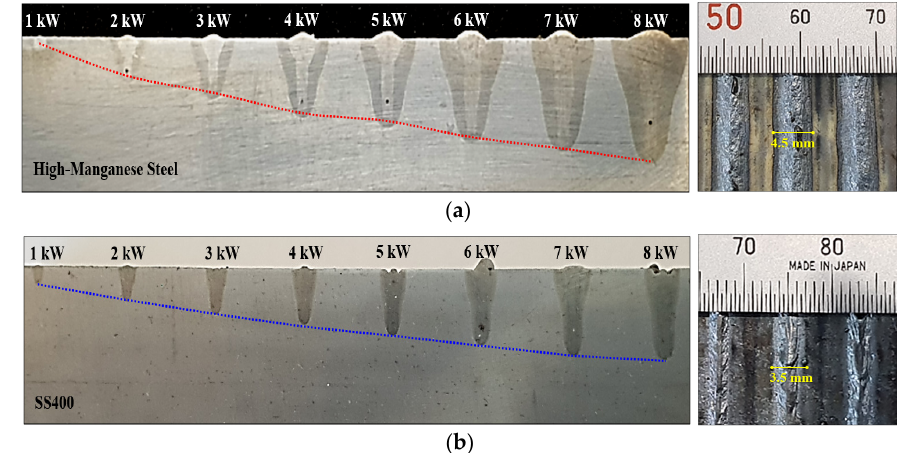
Figure 3. Comparisons between the penetration depths and weld face widths of single laser welding outputs for different materials. ( a ) Penetration depth and weld face width of the laser output for high-Mn steel and ( b ) penetration depth and weld face width of the laser output for SS400 steel.